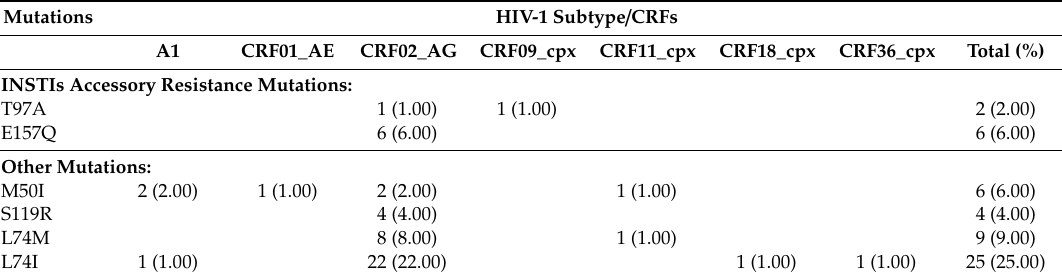
Table 2. INSTIs resistance mutations in cohort